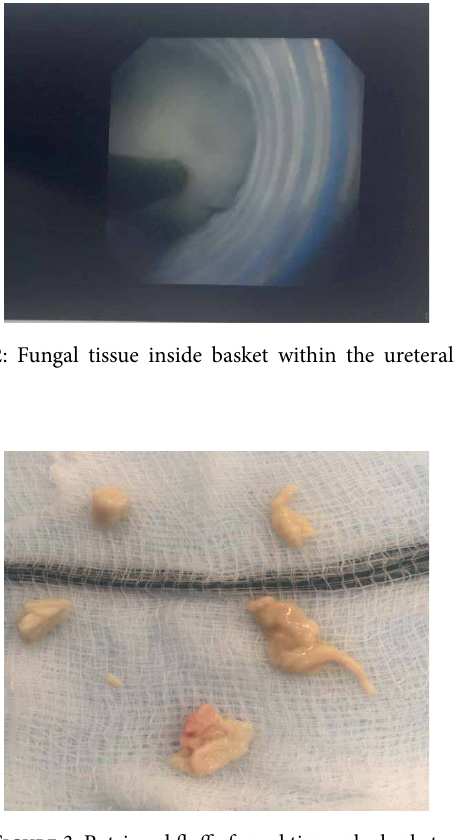
Figure 3: Retrieved fluffy fungal tissues by